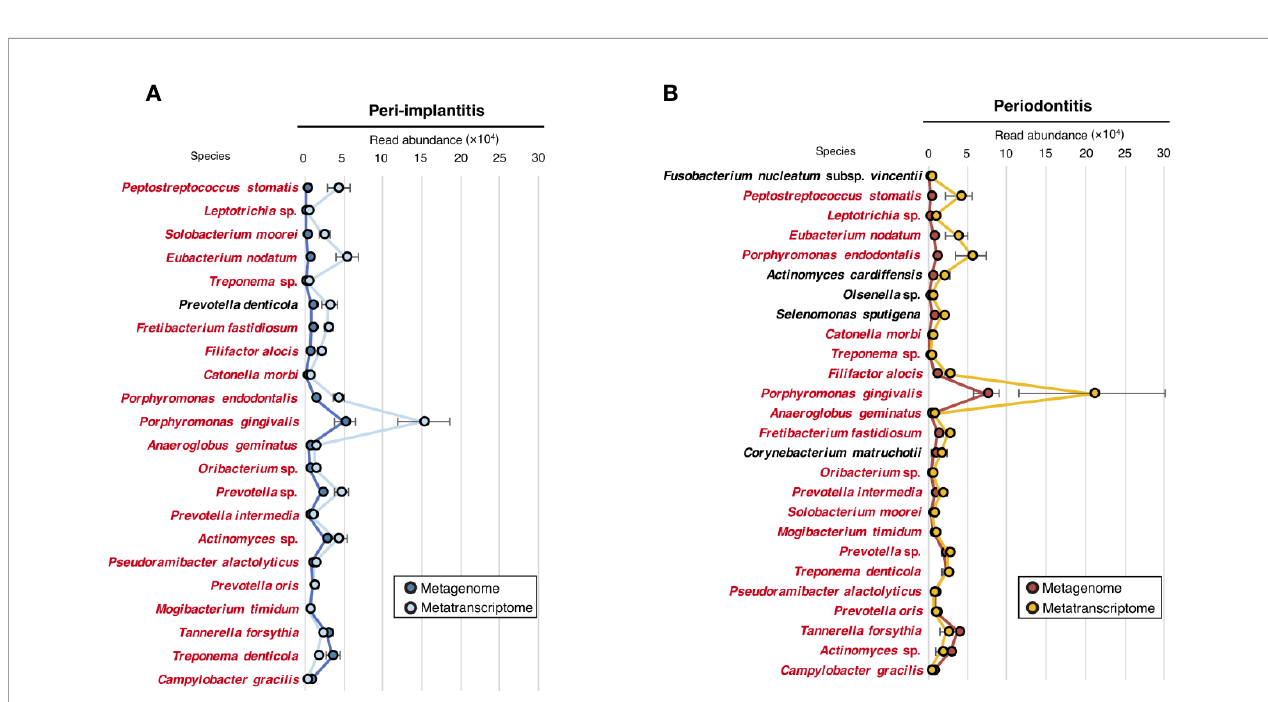
FIGURE 3 | Microbial activity. (A) RNA/DNA ratio of species taxa identi fi ed in peri-implantitis. (B) RNA/DNA ratio of species taxa identi fi ed in periodontitis. Species taxa common to both peri-implantitis and periodontitis are indicated by red